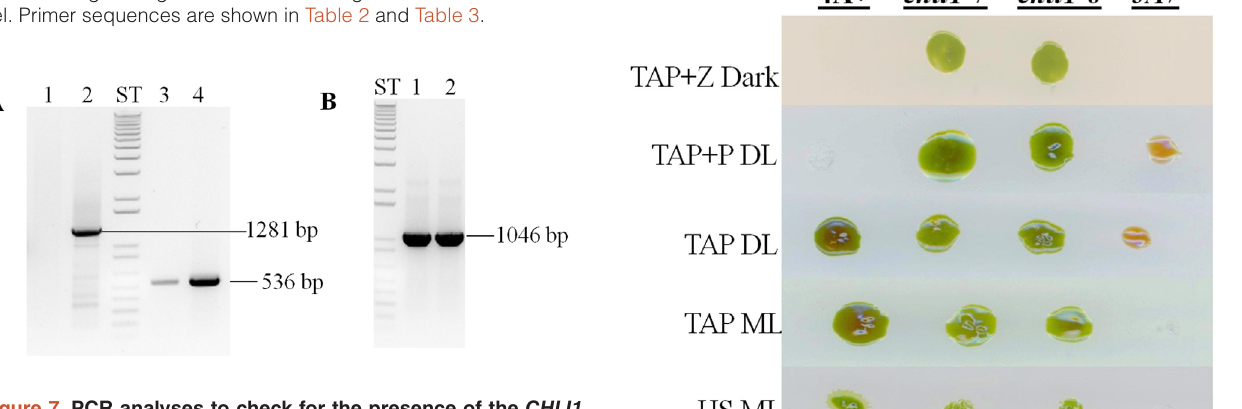
Figure 7. PCR analyses to check for the presence of the CHLI1 and CHLI2 . ( A ) Semi-quantitative RT-PCR analyses of 5A7 and 4A+ using CHLI1 and CHLI2 primers. ( B ) PCR analyses using 5A7 and 4A+ genomic DNA with CHLI2 gene specific primers. Odd numbered lanes denote 5A7 ; even numbered lanes denote 4A+. PCR product sizes (bp) are labeled. ST denotes 1 kb plus DNA ladder. All DNA samples were run on a 1.8% agarose gel. Gene names are given at the top of the gel. Primer sequences are shown in Table 4.